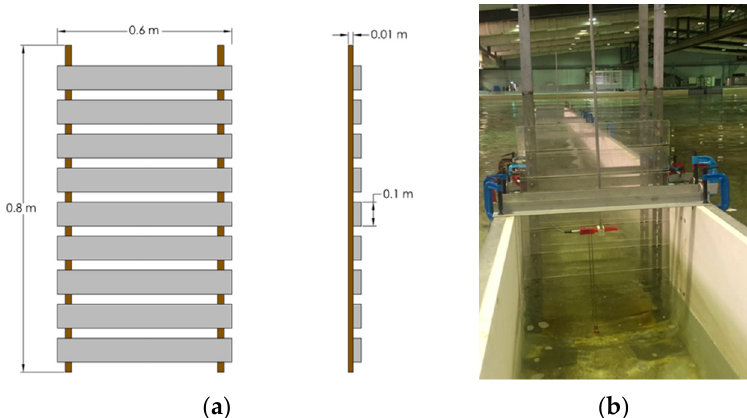
Figure 1. Suggested model design. Conceptual design in ( a ) and actual model fixed in the flume in ( b ). Table 1. Range of wall parameters tested.